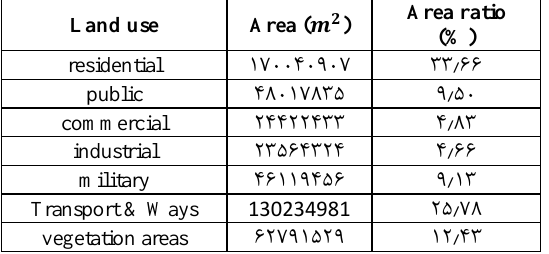
Table 1. Classification of different types of land uses